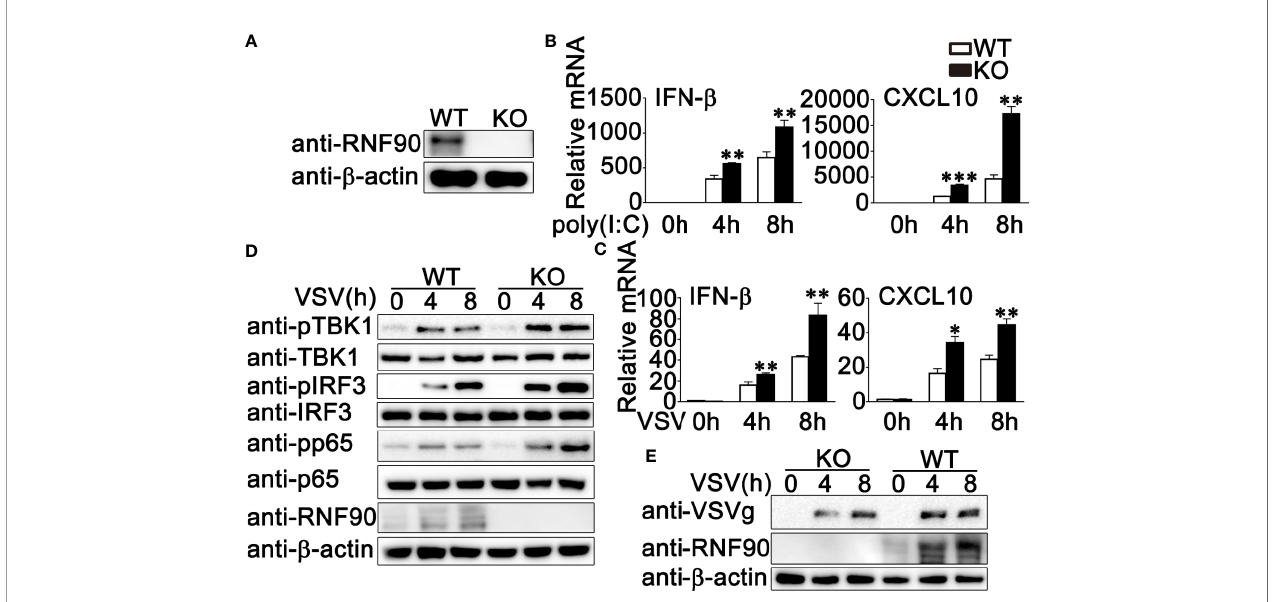
FIGURE 3 | RNF90 de fi ciency promotes RNA virus-triggered innate immune responses in HaCaT cells. (A) WT and RNF90-de fi cient (KO) HaCaT cells were lysed for immunoblot analysis. (B, C) WT and RNF90-de fi cient (KO) HaCaT cells were treated with poly (I:C) (2.5 m g/ml) (B) or VSV (MOI = 1) (C) for indicated time points and then lysed for real-time PCR analysis. (D) WT and RNF90-de fi cient (KO) HaCaT cells were infected with VSV (MOI = 1) for indicated time points and then lysed for immunoblot analysis. (E) WT and RNF90-de fi cient (KO) HaCaT were infected with VSV (MOI = 1) for indicated time points and then lysed for immunoblot analysis. b -actin served as a loading control in all the immunoblot assays. The data are representative of three independent experiments. * P < 0.05, ** P < 0.01, *** P <